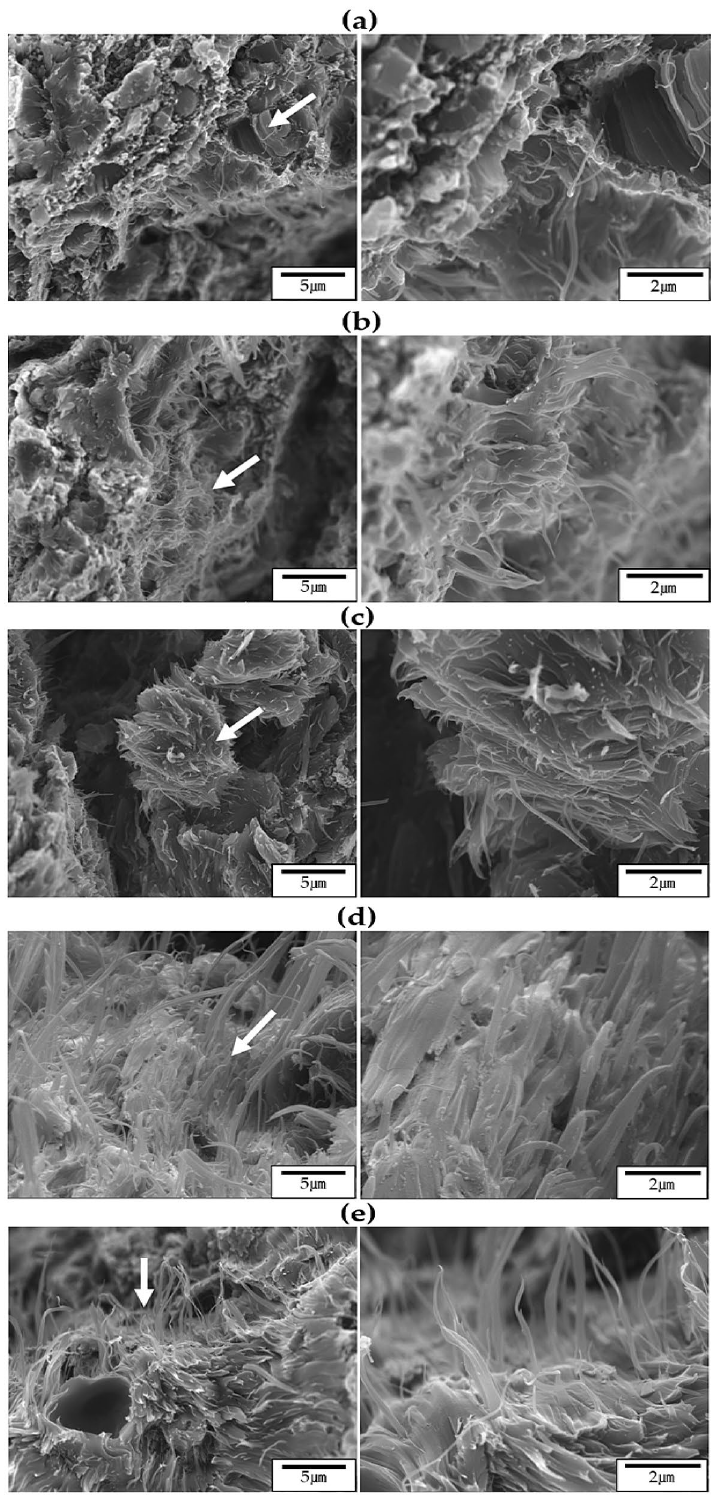
Figure 7. SEM micrographs of TLCP fibers with various heat treatment temperatures: ( a ) as-spun, ( b ) 190/3, ( c ) 210/3, ( d ) 230/3, and ( e ) 250/3. Micrographs with increasing magnification levels fr om left to